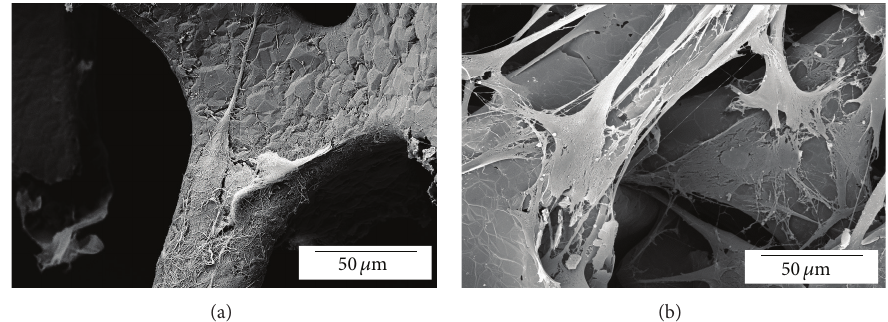
Figure 5: Periodontal ligament stem cell in 3DGP after 3 (a) and 5 days (b) on culture. Cells are able to attach and proliferate into the three-dimensional surface of the graphene-based